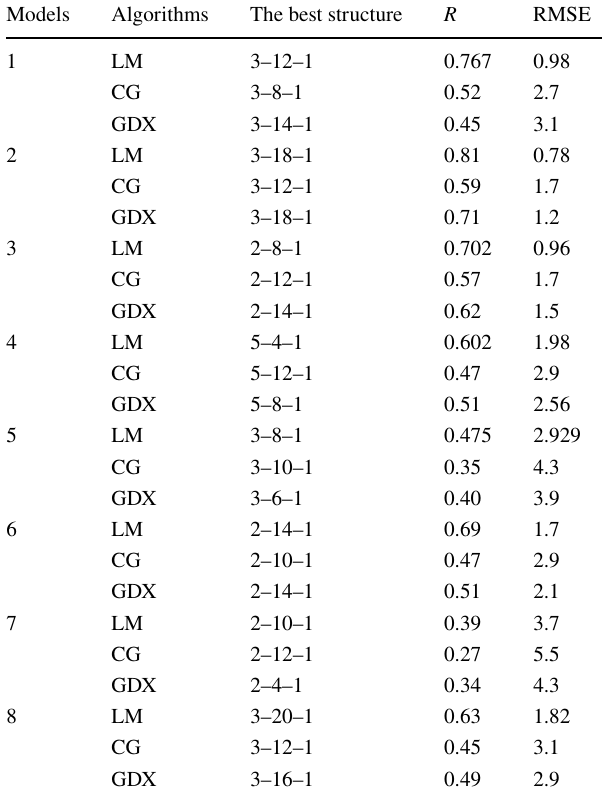
Table 4 The results of karst springs discharge simulation by the use of ANN in the eight network structure in the testing stage Models